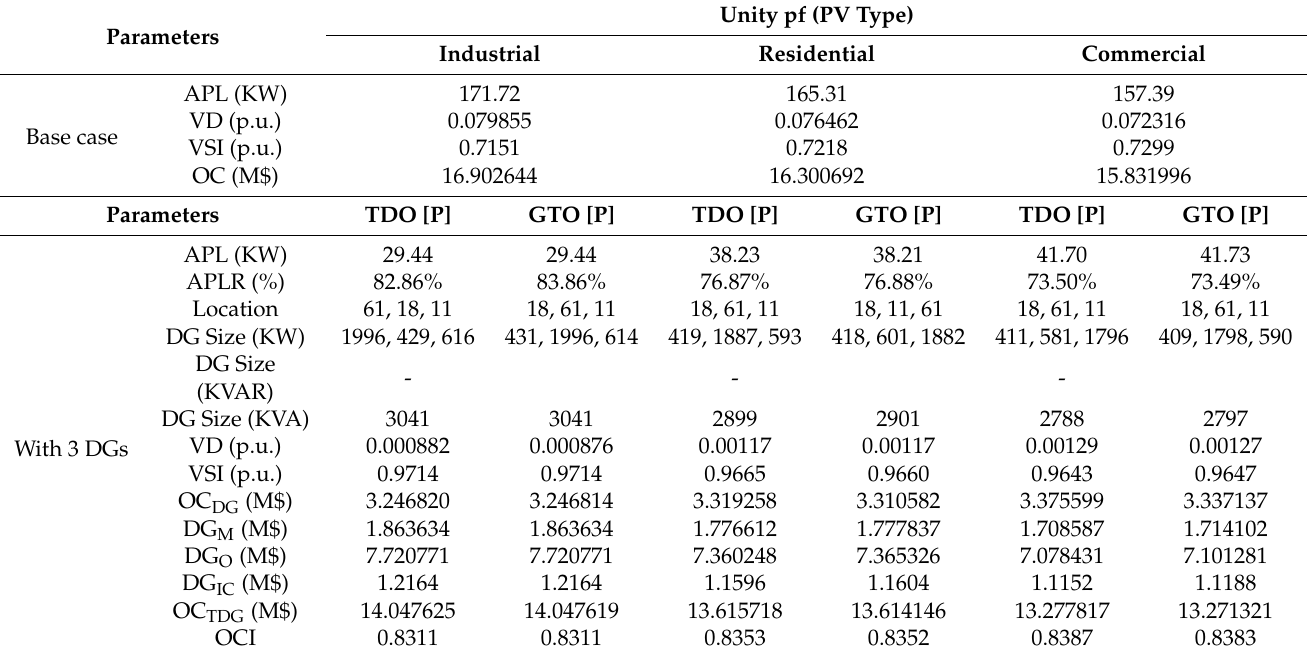
Table 16. Results of OADG for 69 bus RDN for MOF at unity pf (PV Type) in VP load model.